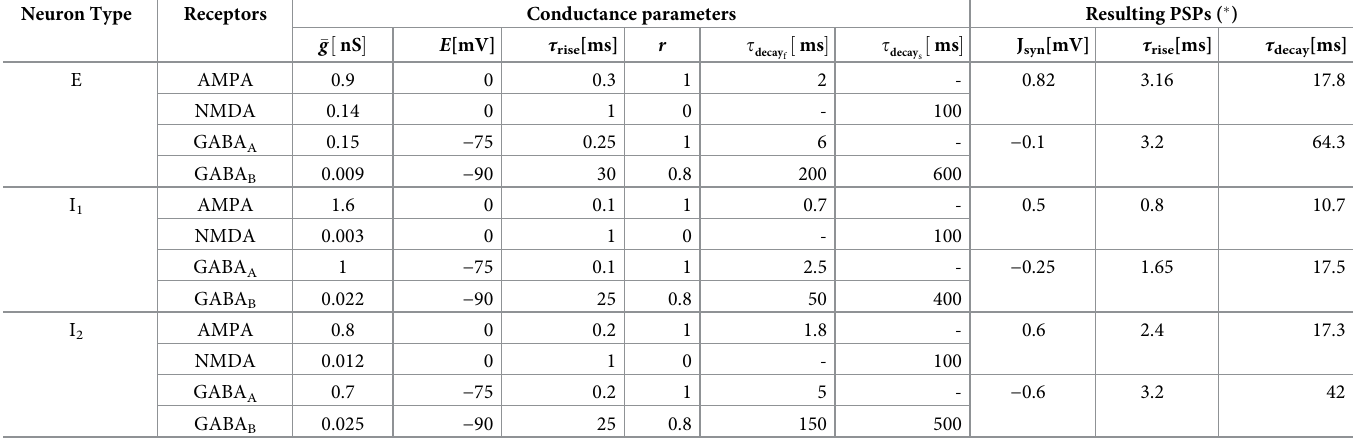
Table 2. Differential receptor expression in the different neuron types. The kinetics and relative conductance of the different receptors that make up an inhibitory or excitatory synapse onto each neuron results in post-synaptic potentials with equally discernible kinetics. The parameters were chosen based on the corresponding receptor conductance data, if directly available and/or on the characteristics of the resulting PSPs, resulting in a substantial diversity of postsynaptic responses (see Fig 2c). ( � ) The PSP values reported in this table were obtained by fitting a double exponential function to single, spike-triggered PSPs, recorded at rest for E neurons and at a fixed holding potential of − 55 mV for I neurons.